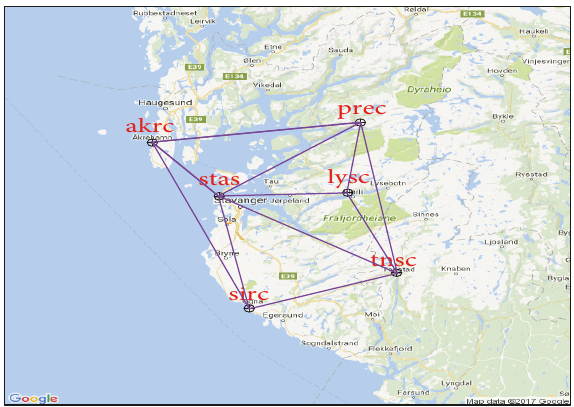
Figure 19: Test area used in this investigation, from Rogaland region. Composed of 6 reference